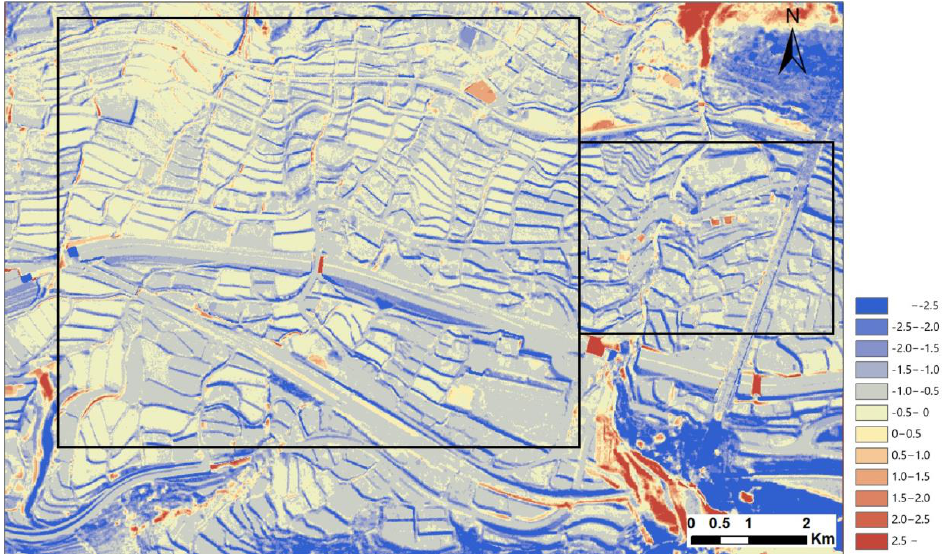
Figure 9. DTM difference in the co-event period (2013.1–2016.4) for Tateno district. The average value within the black squares was − 0.7